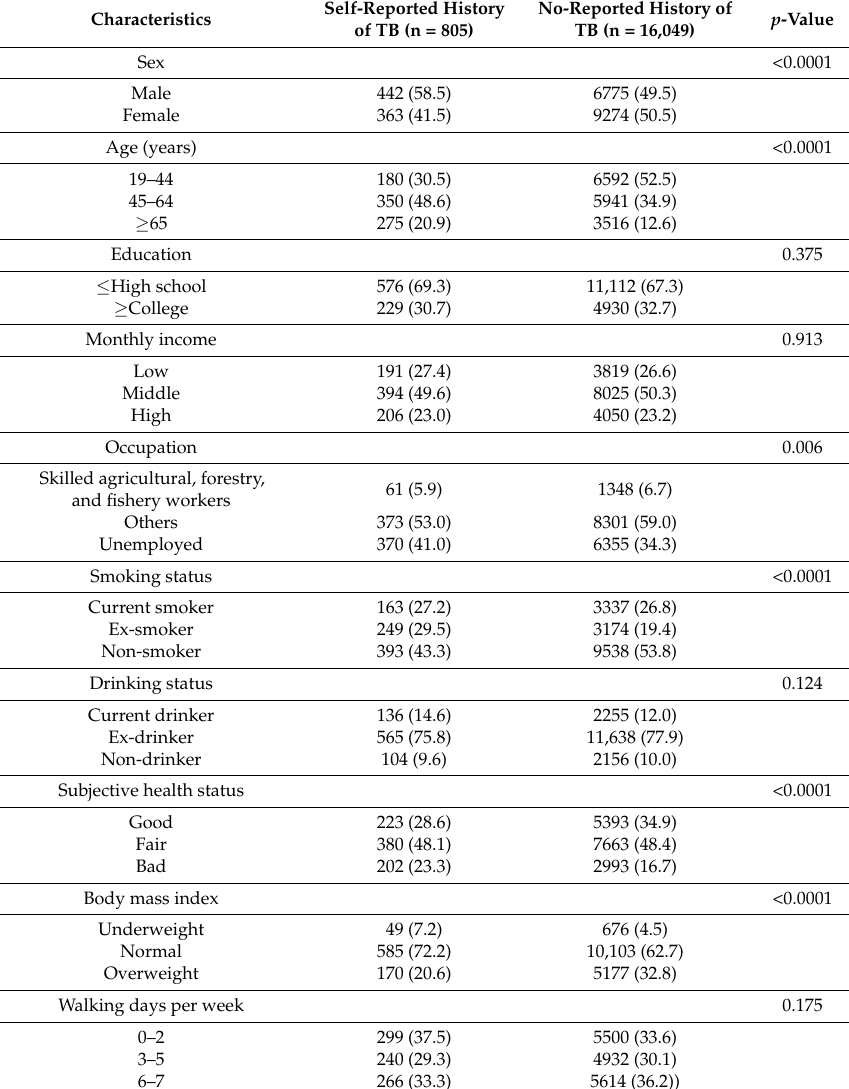
Table 1. General characteristics of subjects by history of TB